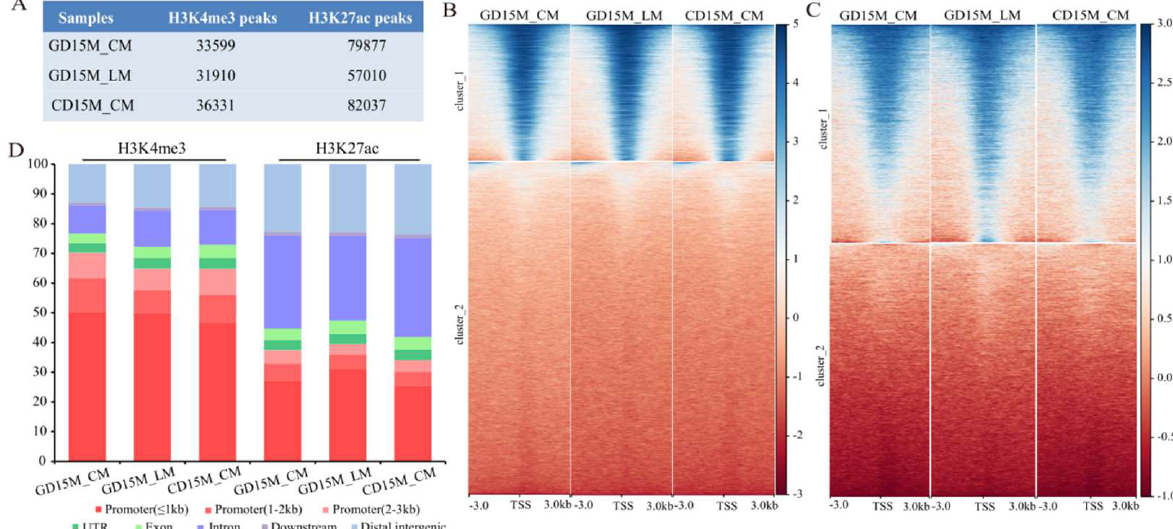
Figure 4. Genome−wide landscape of H3K4me3 and H3K27ac modifications in M_CM and M_LM on GD15 and M_CM on CD15. ( A ) The number of H3K4me3 and H3K27ac peaks identified in M_CM and M_LM. ( B ) Heatmap of the H3K4me3 signals within ± 3 kb from the TSS that was developed according to gene expression level. ( C ) Heatmap of the H3K27ac signals within ± 3 kb from the TSS that was developed according to gene expression level. ( D ) Distribution of the H3K4me3 and H3K27ac modification regions in genomic regions. GD15, day 15 of pregnancy; CD15, day 15 of the estrous cycle; M, the mesometrial side of the uterus; CM, the circular muscle of myometrium; LM, the longitudinal muscle of myometrium.